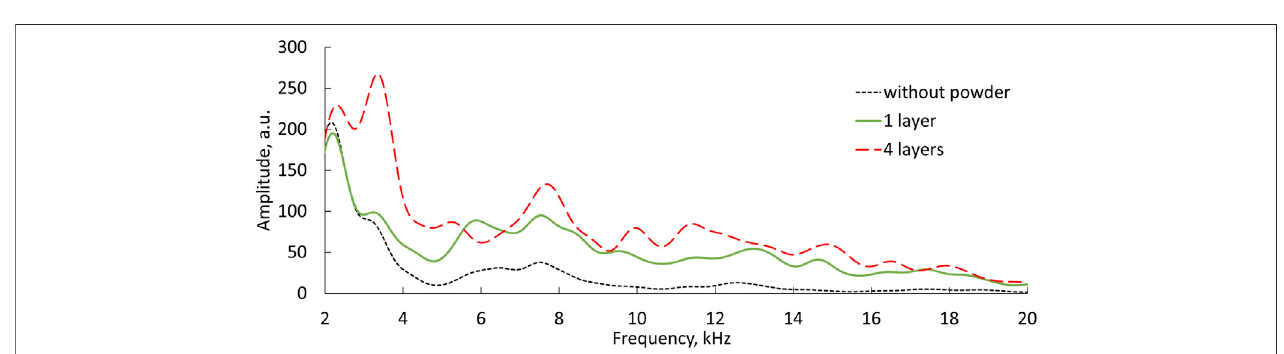
FIGURE 11 | Cumulative amplitude of AE signals for single layers in different sets of powder thickness: 1 layer (30 µm as reference, solid line), four layers (120 μ m, dashed line), and without powder (dotted line).